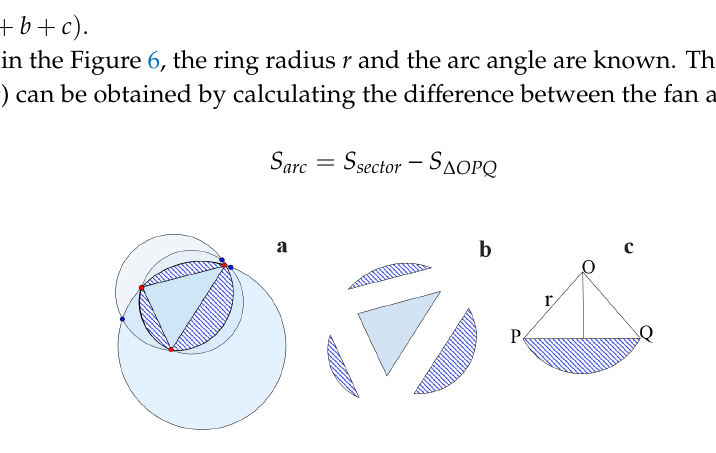
Figure 6. Schematic diagram of size calculation of overlap area among rings, ( a ) intersection area of the three rings; ( b ) division of overlapping area; ( c ) diagram of the calculation of arc